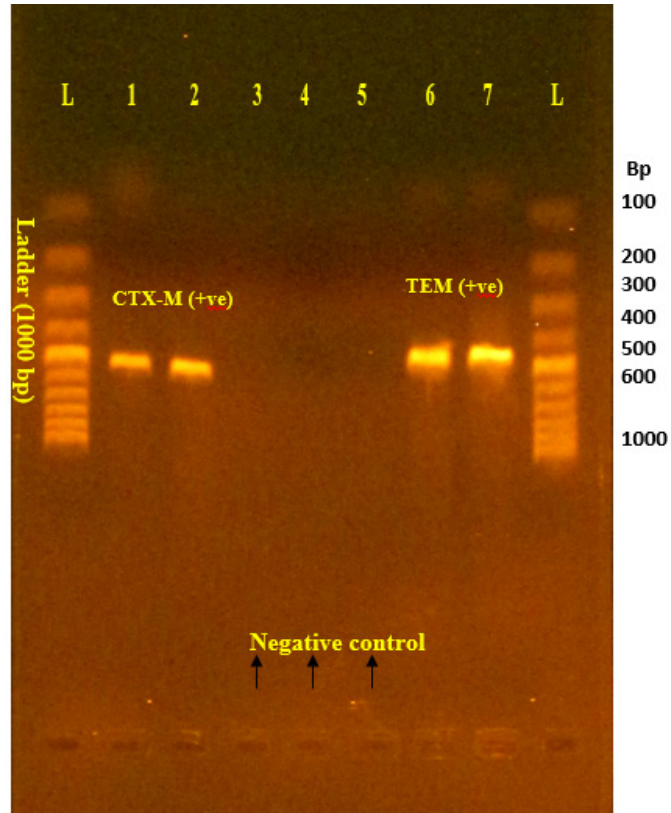
Figure 4. Electrophoresis of Polymerase Chain Reaction (PCR) products of the bla TEM and bla CTX-M genes of E. coli on agarose gel.